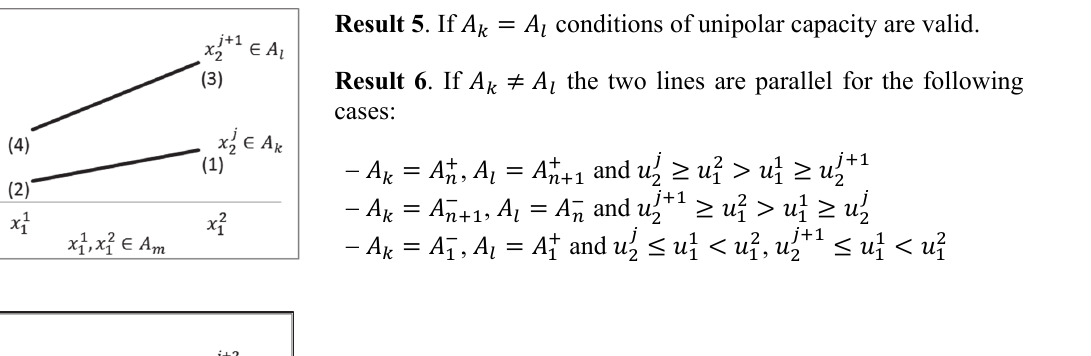
), ≠ 𝐴 ≠ 𝐴 (cid:3038) (cid:3039) (cid:3041)